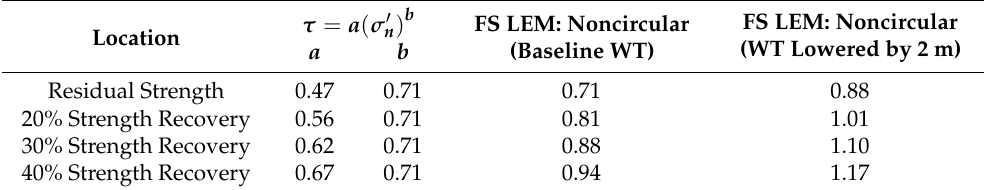
Table 4. Updated power curve parameters for strength recovery using drained residual strength ring shear results with FS values for the baseline and lowered water tables